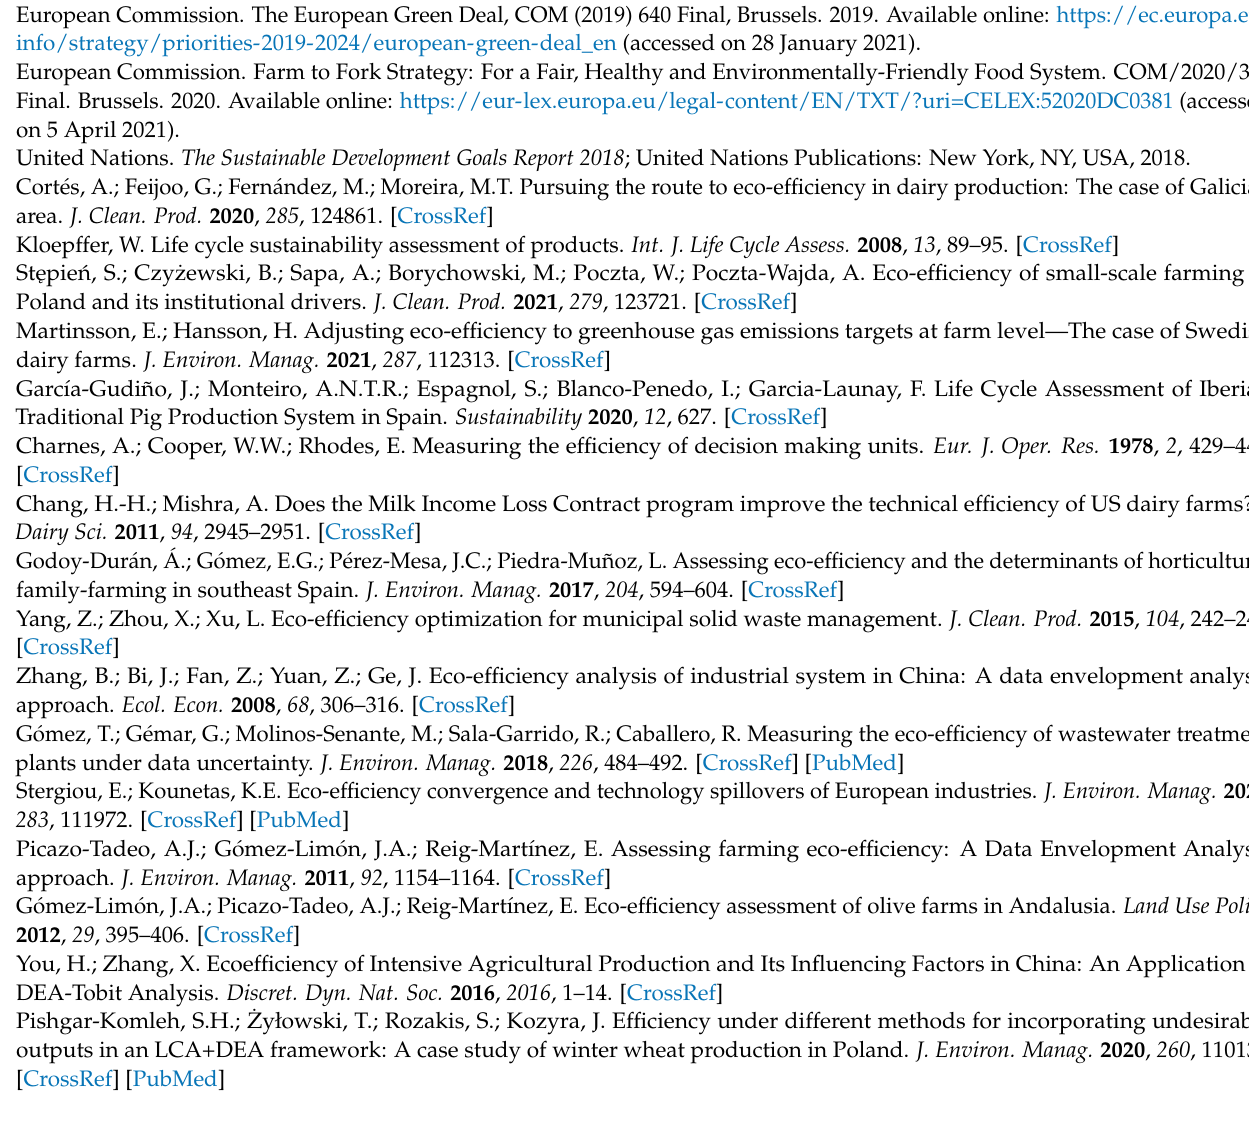
Table S2: Input/output target and operational reduction percentages for inefficient farms. Table S3: Benchmarks intensities of inefficient